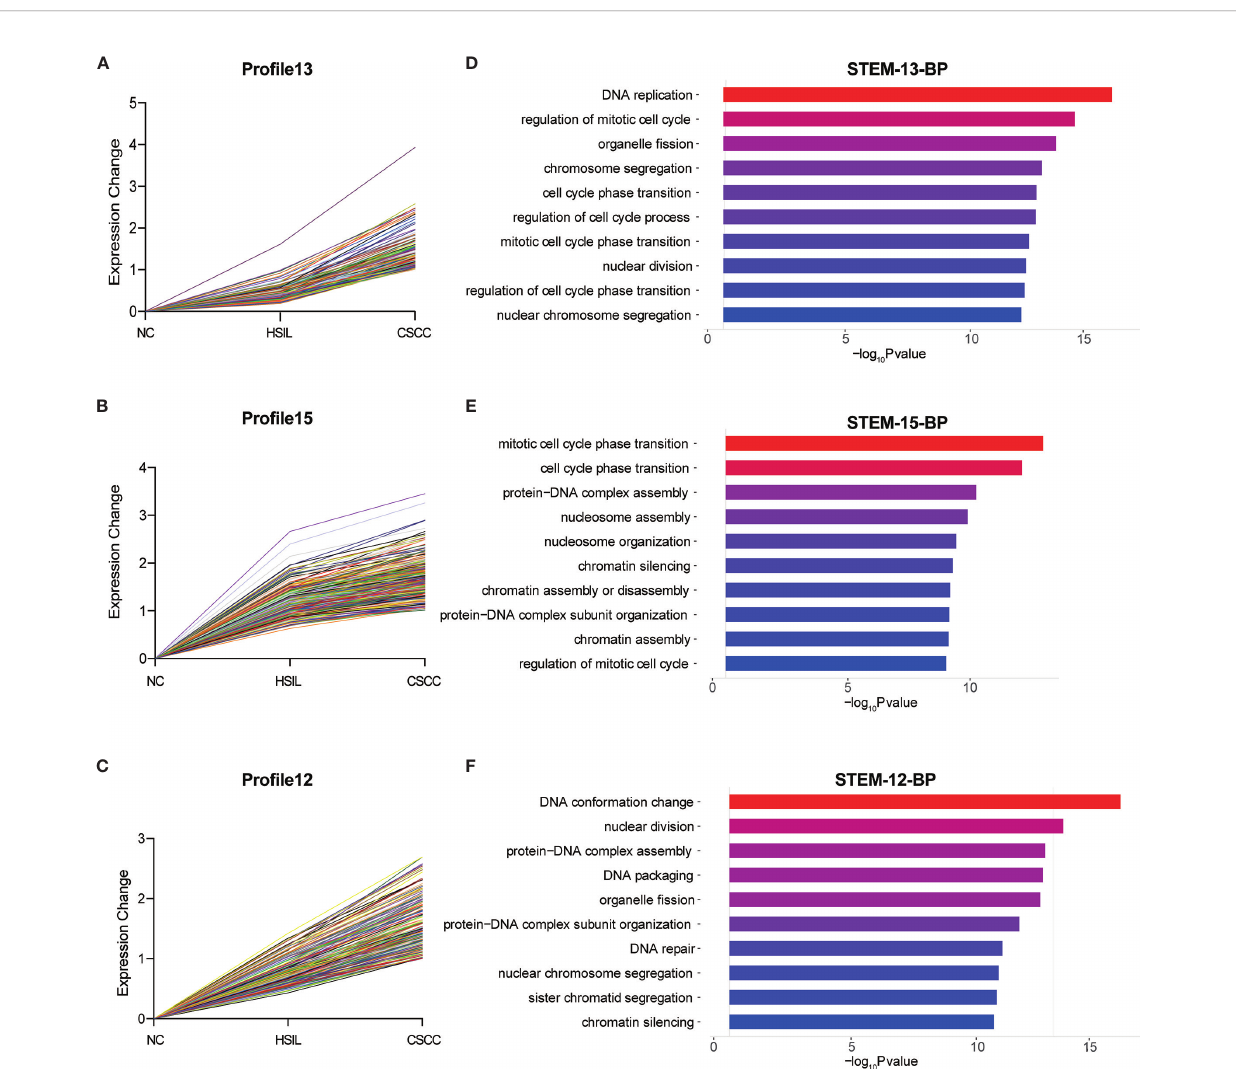
FIGURE 5 | Expression patterns of pro fi les 13 (A) , 15 (B) and 12 (C) and GO analysis of genes clustered in 13 (D) , 15 (E) and 12 (F) . GO, Gene Ontology; BP, biological process; STEM, short time-series expression